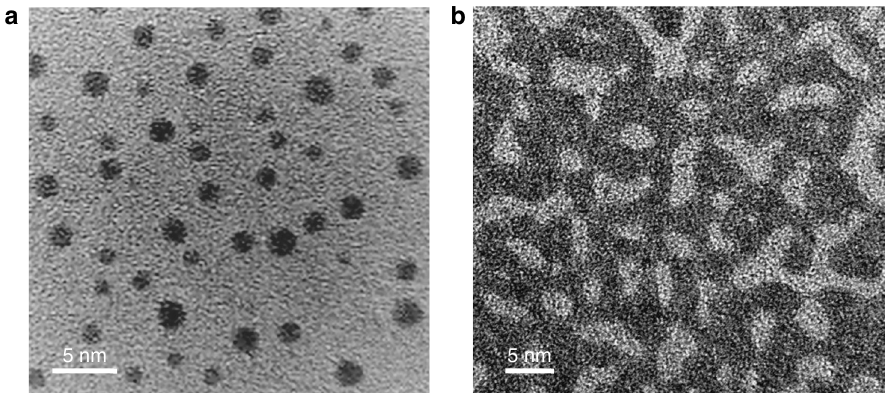
Fig. 1 Bright fi led HRTEM images of the PdSi ultrathin fi lms. a The discrete amorphous PdSi nanoparticles (NPs) deposited with low dose (one dose) with size range of 1 ~ 3 nm. b The thin PdSi fi lm deposited with high doses ( fi ve doses) shows the bicontinuous